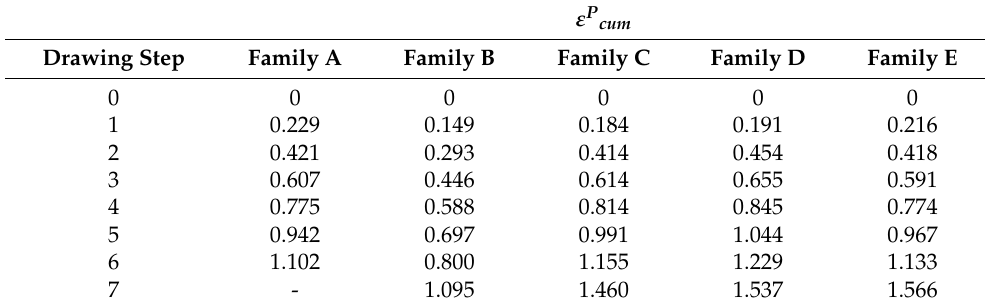
Table 3. Cumulative plastic strain of the progressively drawn steels for the five families [4]. Drawing